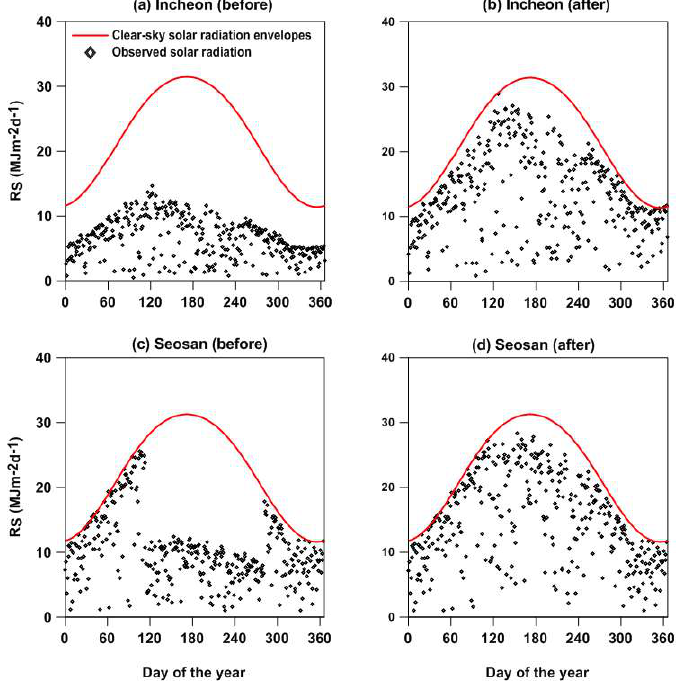
Figure 2. Adjustment of daily solar radiation using the clear-sky envelope for the Incheon station in 1980 (( a ) and ( b )), and the Seosan station in 1982 (( c ) and ( d )); results for before and after adjustment are shown.